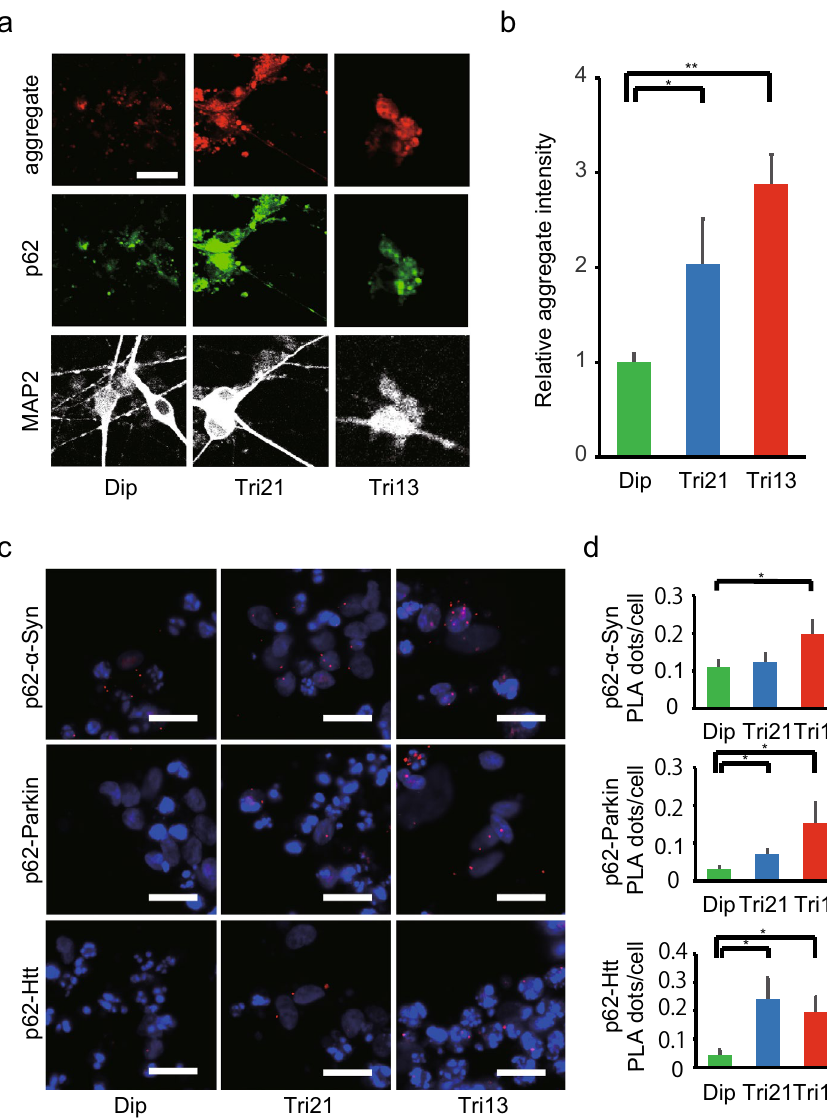
Figure 4. Aggregation of neurodegenerative disorder-associated proteins in trisomic neurons. ( a ) Representative images showing immunocytochemical staining for aggregates (red), p62 (green), and MAP2 (white) in NGN2-neurons on day 14. Scale bar = 20 μm. ( b ) Relative aggregate intensity per cell in NGN2- neurons (D14). * P < 0.05, ** P < 0.001, n = 5–13 per clone. ( c ) PLA to detect the interaction between p62 and α-Syn, Parkin, or Htt in NGN2-neurons. PLA signals are seen as red dots. Hoechst 33342 counterstaining appears in blue. Scale bar = 20 μm. ( d ) Quantification of PLA signals (red dots) per cell. Data are presented as mean ± SEM. * P < 0.05, n = 3–6 per